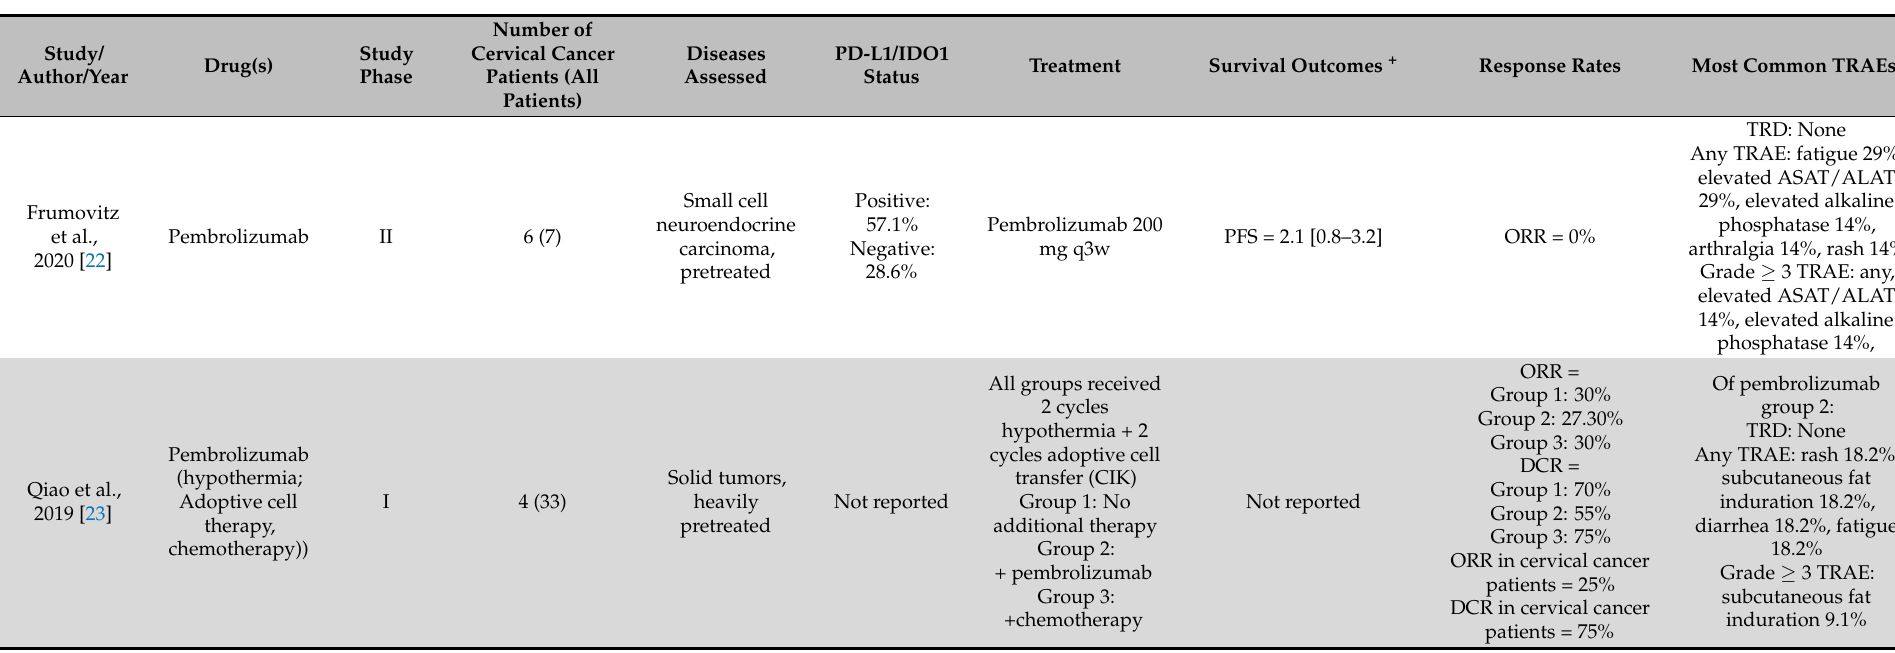
Table 2. Overview and results of clinical trials assessing immune checkpoint inhibitors in patients with solid tumors, including cervical cancer